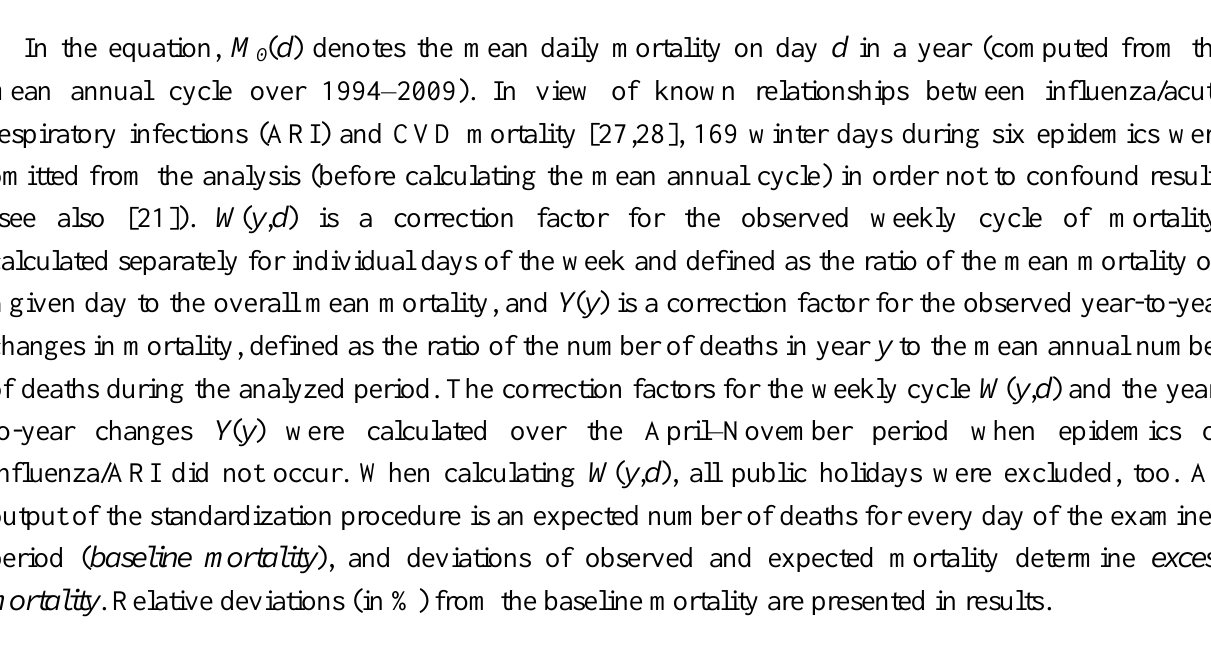
Figure 1. Study areas. Red triangles show the meteorological stations